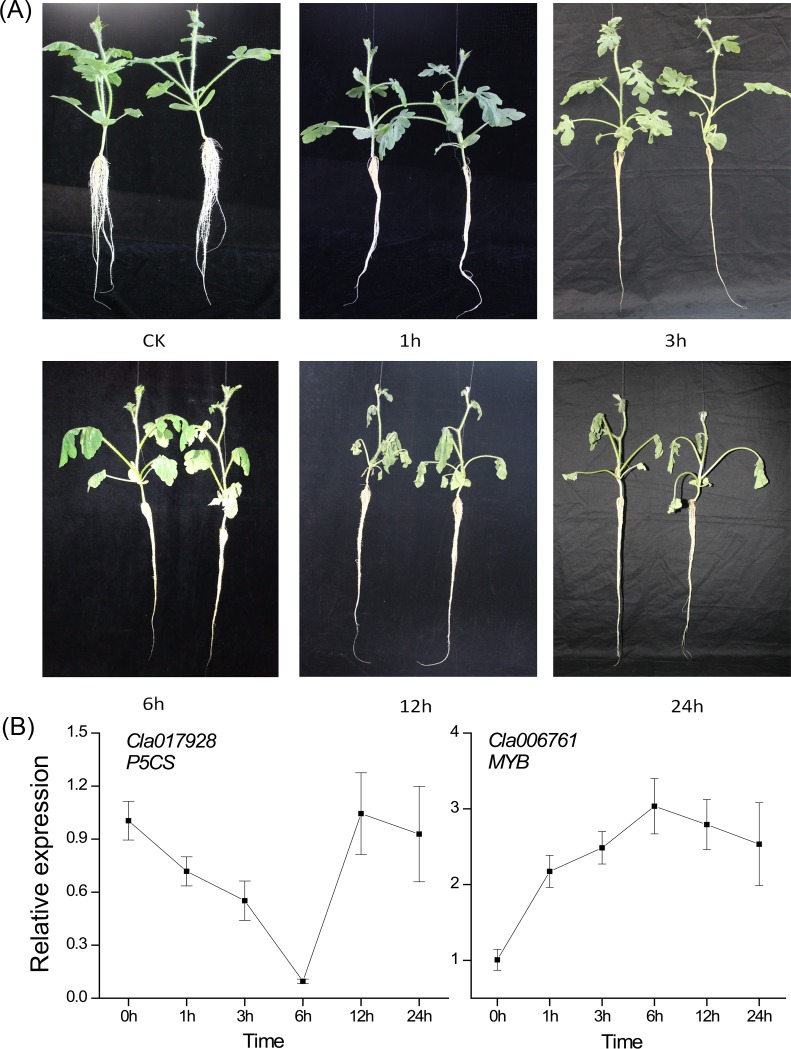
Choosing the appropriate time point for transcriptome sequencing.(A) Phenotypes of watermelon seedlings (M08) under osmotic stress at 0h, 1h, 3h, 6h, 12h and 24h. (B) The dynamic response of the expression of Cla017928 (P5CS) and Cla006761 (MYB) to osmotic stress. Hydroponically cultivated watermelon seedlings were treated with 20% PEG6000. Data in (B) are the means of three replicates (±SD).